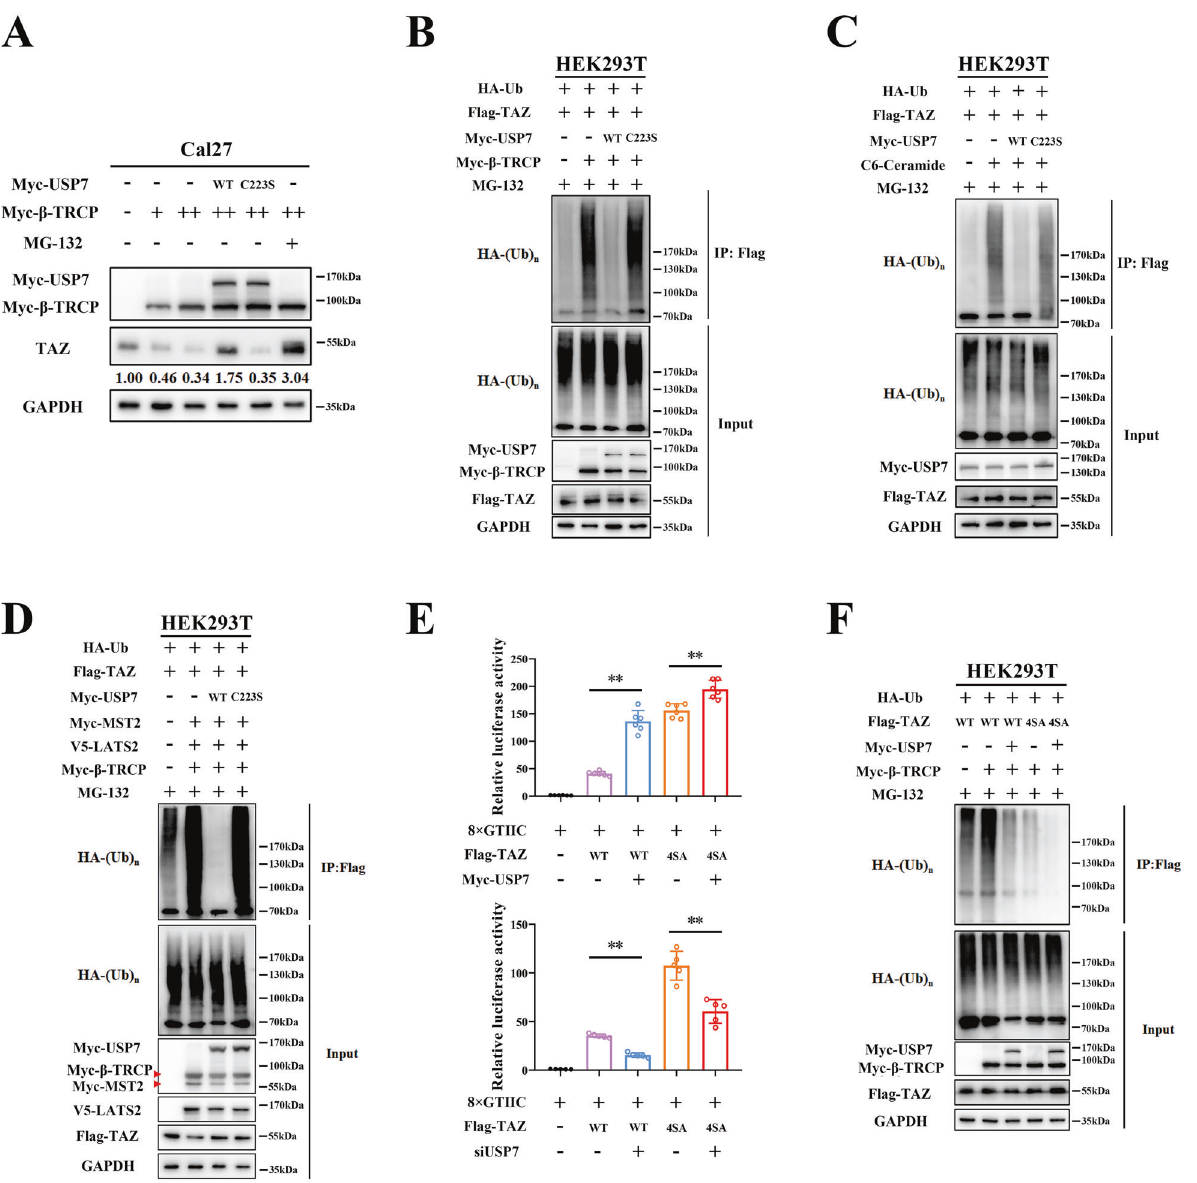
Fig. 5 USP7 and β -TRCP cooperatively maintain TAZ overexpression in HNSCC. A Endogenous TAZ protein abundance was measured in Cal27 cells transfected with Myc-USP7 (WT/C223S), dosage of β -TRCP (0, 0.5, 1 μ g) or treated with MG-132 (10 μ M, 8 h). B The ubiquitination of TAZ was determined in HEK293T cells transfected with indicated plasmids. HEK293T cells were co-transfected with HA-Ub, Flag-TAZ, Myc-USP7 (WT/C223S) and/or Myc- β -TRCP plasmids. Then cell lysates were subjected to immunoprecipitation by anti-Flag antibody and immunoblotted with anti-HA antibody. C The ubiquitination of TAZ was determined in HEK293T cells transfected with indicated plasmids and chemicals. HEK293T cells were co-transfected with HA-Ub, Flag-TAZ, Myc-USP7 (WT/C223S) with/without C6-Ceramide (25 μ M, 6 h) treatment. Then cell lysates were subjected to immunoprecipitation by anti-Flag antibody and immunoblotted with anti-HA antibody. D The ubiquitination of TAZ was determined in HEK293T cells transfected with indicated plasmids. HEK293T cells were co-transfected with Flag-TAZ, HA-Ub, Myc-MST2, V5- LATS2 and Myc- β -TRCP. Then cell lysates were subjected to immunoprecipitation by anti-Flag antibody and immunoblotted with anti-HA antibody. E Luciferase activities on TEAD-binding site (8×GTIIC-luciferase reporter plasmid) were determined in HEK293T cells transfected with Flag-TAZ (WT/4SA), Myc-USP7 plasmids (upper panel) or siUSP7 (lower panel). F The ubiquitination of TAZ was determined in HEK293T cells transfected with indicated plasmids. HEK293T cells were co-transfected with Flag-tagged TAZ wide-type, nuclear-localized mutant TAZ 4SA , Myc-USP7 and Myc- β -TRCP. Cells were further treated with MG-132 (10 μ M, 8 h) before collection. Then cell lysates were subjected to immunoprecipitation by anti-Flag antibody and immunoblotted with anti-HA antibody. Data were presented with representative images from three independent experiments. * p < 0.05, ** p <